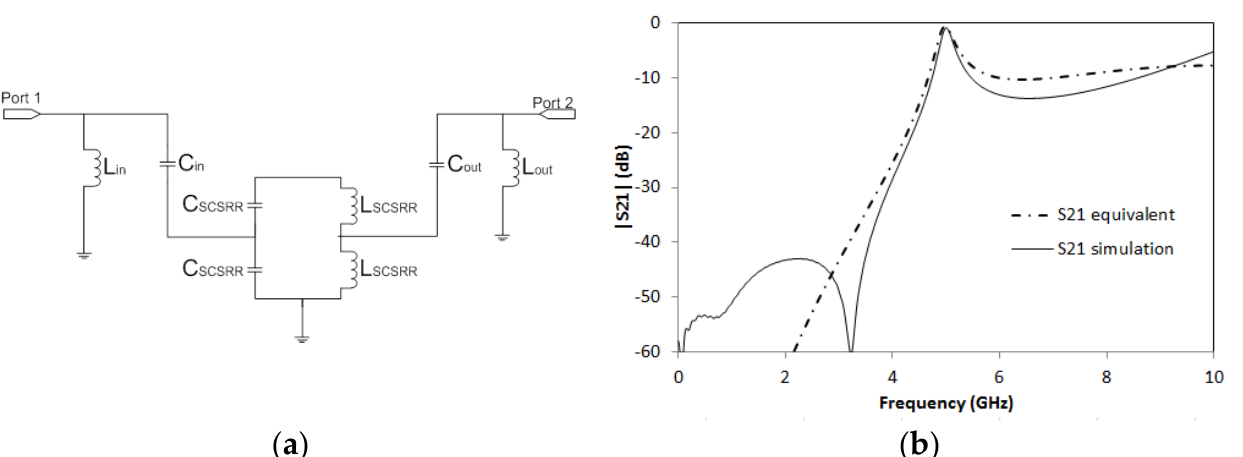
Figure 4. ( a ) Equivalent circuit model for SCSRR Micro-Resonator. ( b ) Full wave simulation results for S21 (solid black line) compared to the simulated S21 obtained with the equivalent circuit model (dash-dotted line).